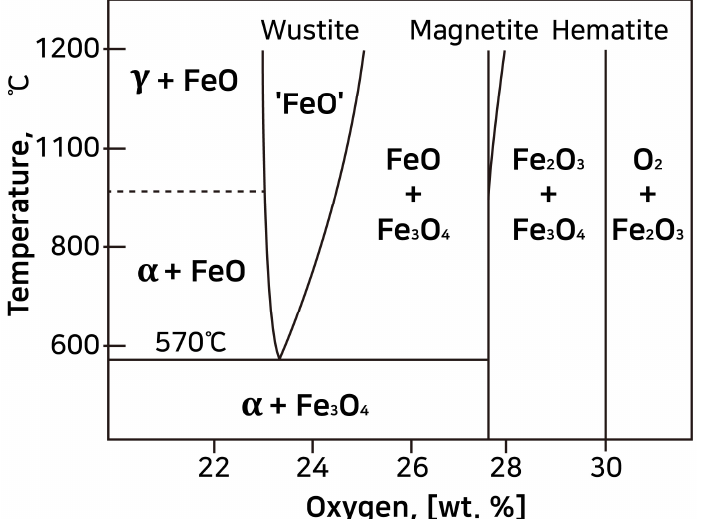
Figure 14. Iron–oxygen phase diagram.